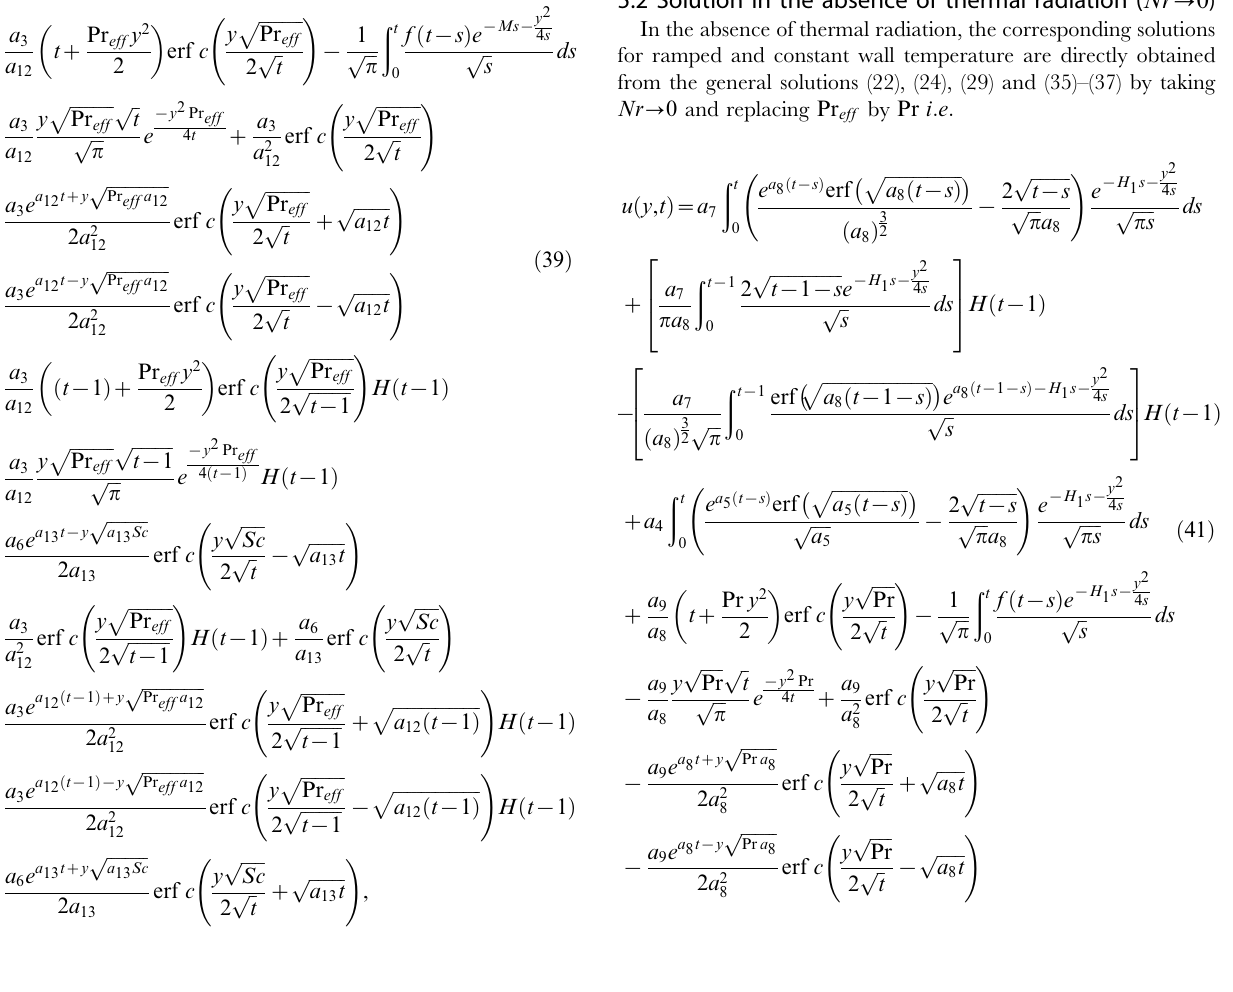
p (cid:7) 2 ffiffiffiffiffiffiffiffiffiffiffiffiffiffiffiffi t { 1 { s ffiffiffiffiffiffiffiffiffiffiffiffiffiffiffiffiffiffi a 13 t p { ffiffiffiffiffiffiffi a 13